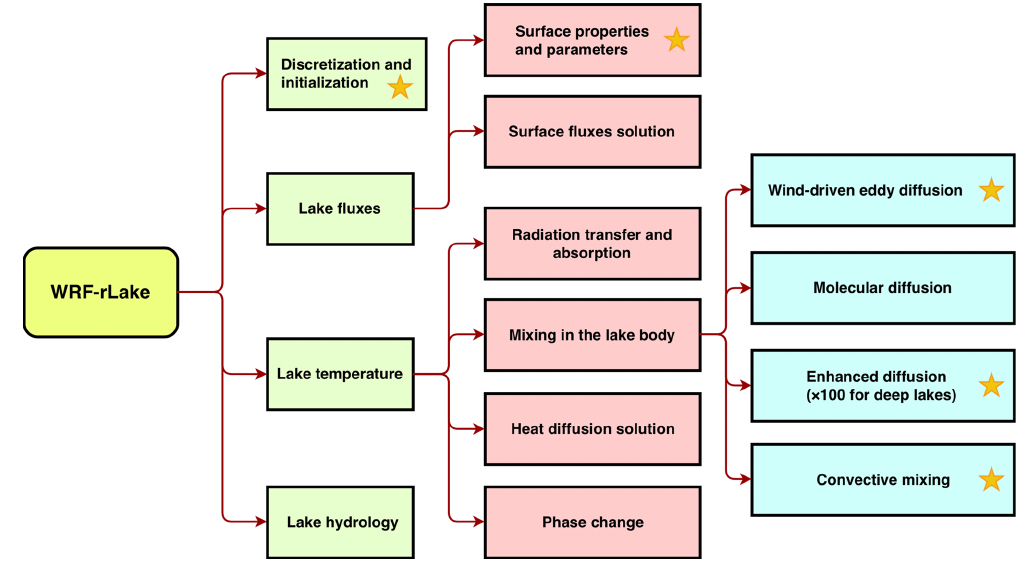
Figure 1. Flow chart of the WRF-rLake model. The yellow star indicates the process is modified or newly added.